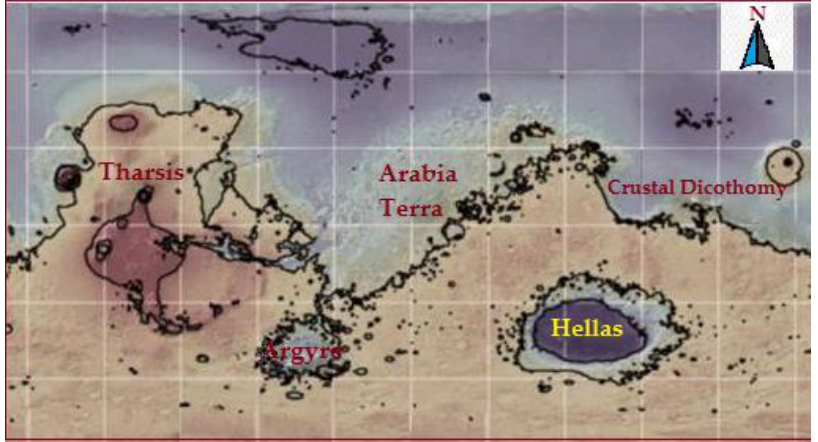
Figure 2. Morphological dichotomy on Mars.